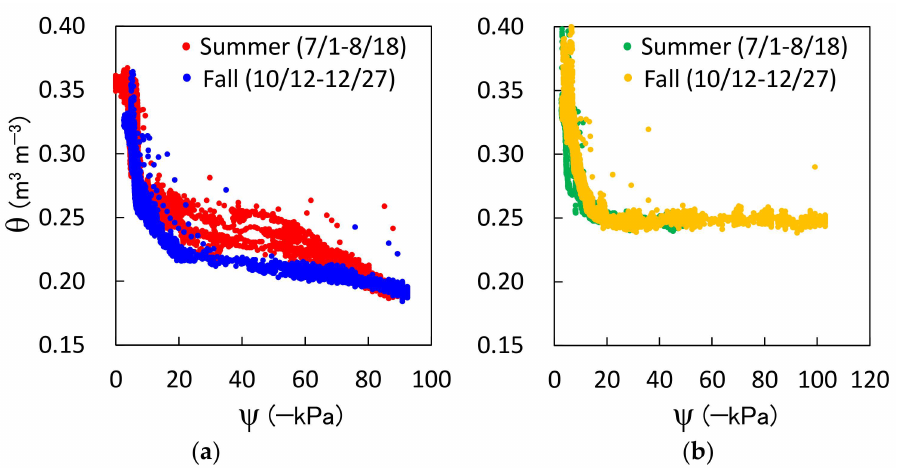
Figure 8. In situ water retention curves were obtained with the new sensors installed at depths of ( a ) 10 cm and ( b ) 20 cm. The different colored plots indicate the different periods: summer (from 1 July to 18 August 2021) and fall (from 12 October to 27 December